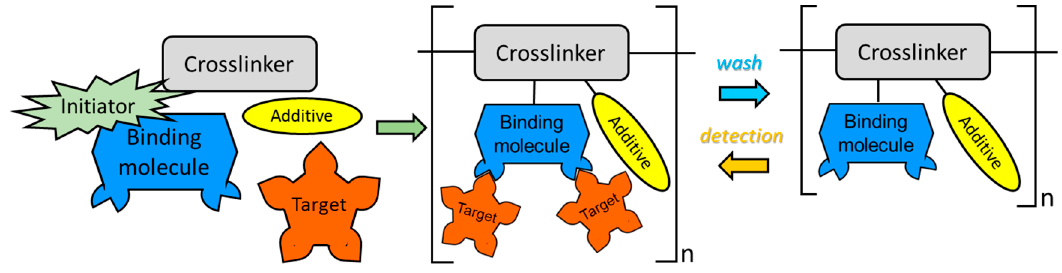
Figure 29. Brief synthesis and reaction processes for a MIP, showing the most relevant molecules involved.